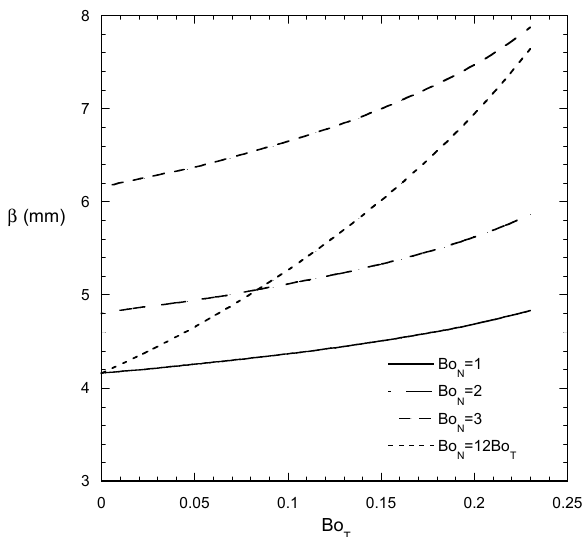
Figure 2. Evolution of droplet length β with Bo T and for several scenarios for Bo N variation (constant or proportional to Bo T ). (V A = 5 mm 2 , θ a = 60°, θ r = 40°, θ ο = 60°, starting transient).